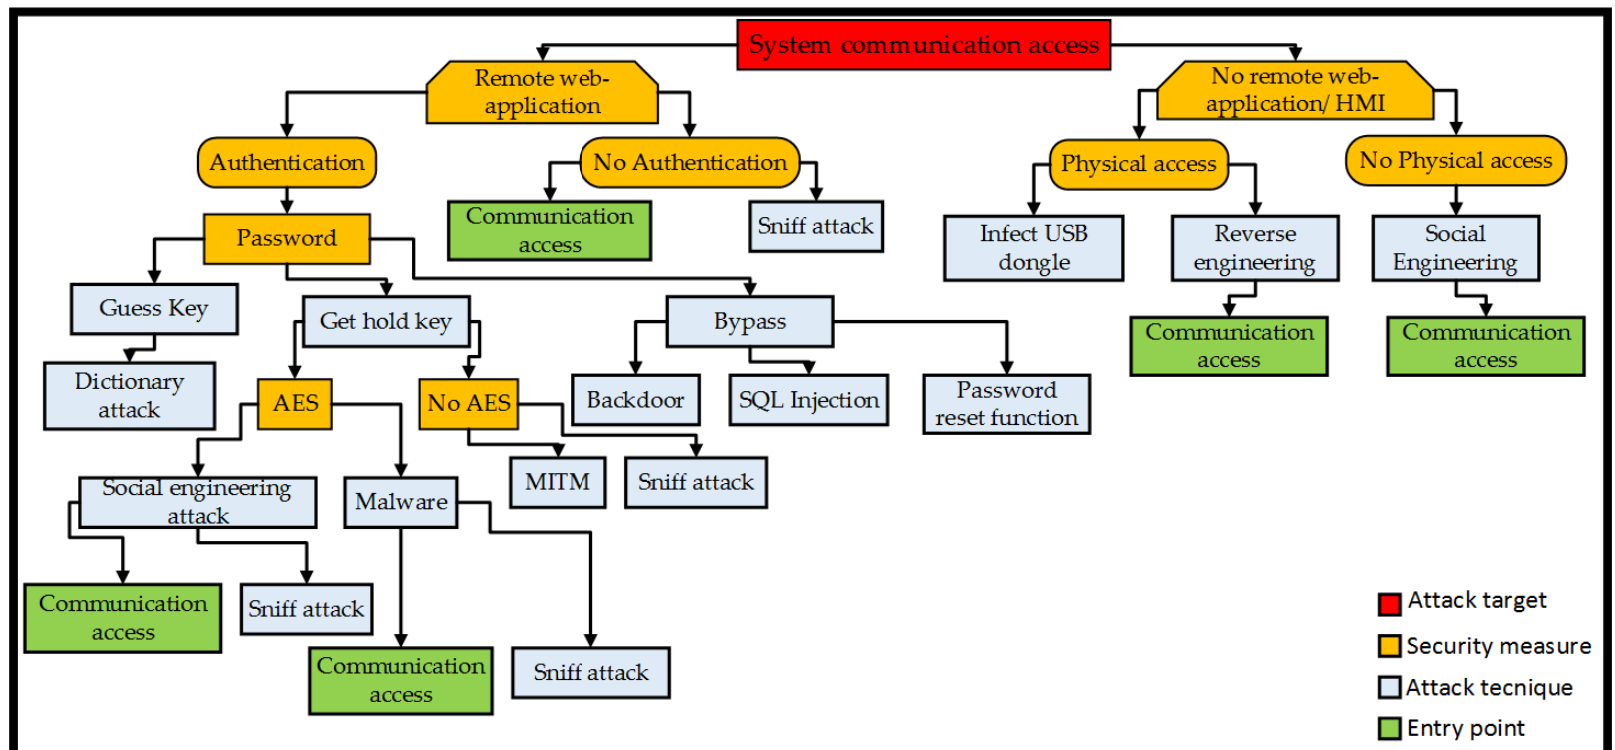
Figure 8. System communication access attack tree. MITM: Man-in-the-middle.